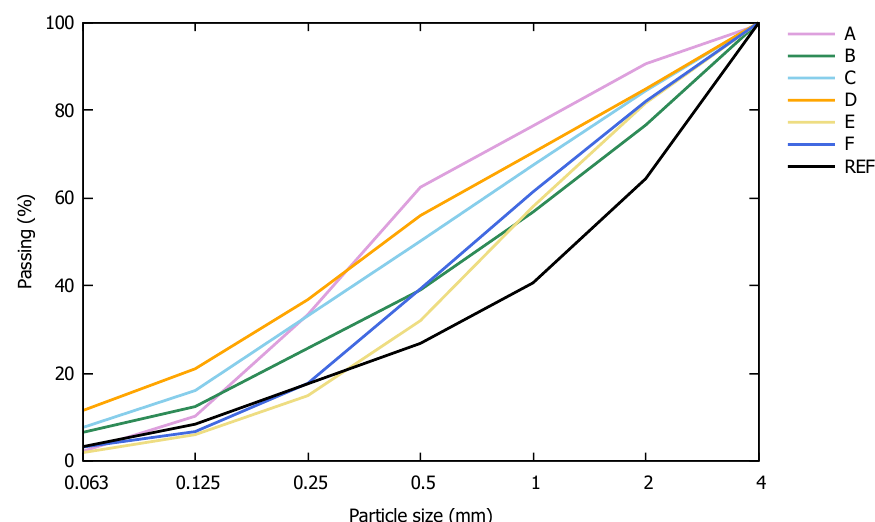
Figure 1. Particle size distribution of the used fine recycled aggregates (FRA).